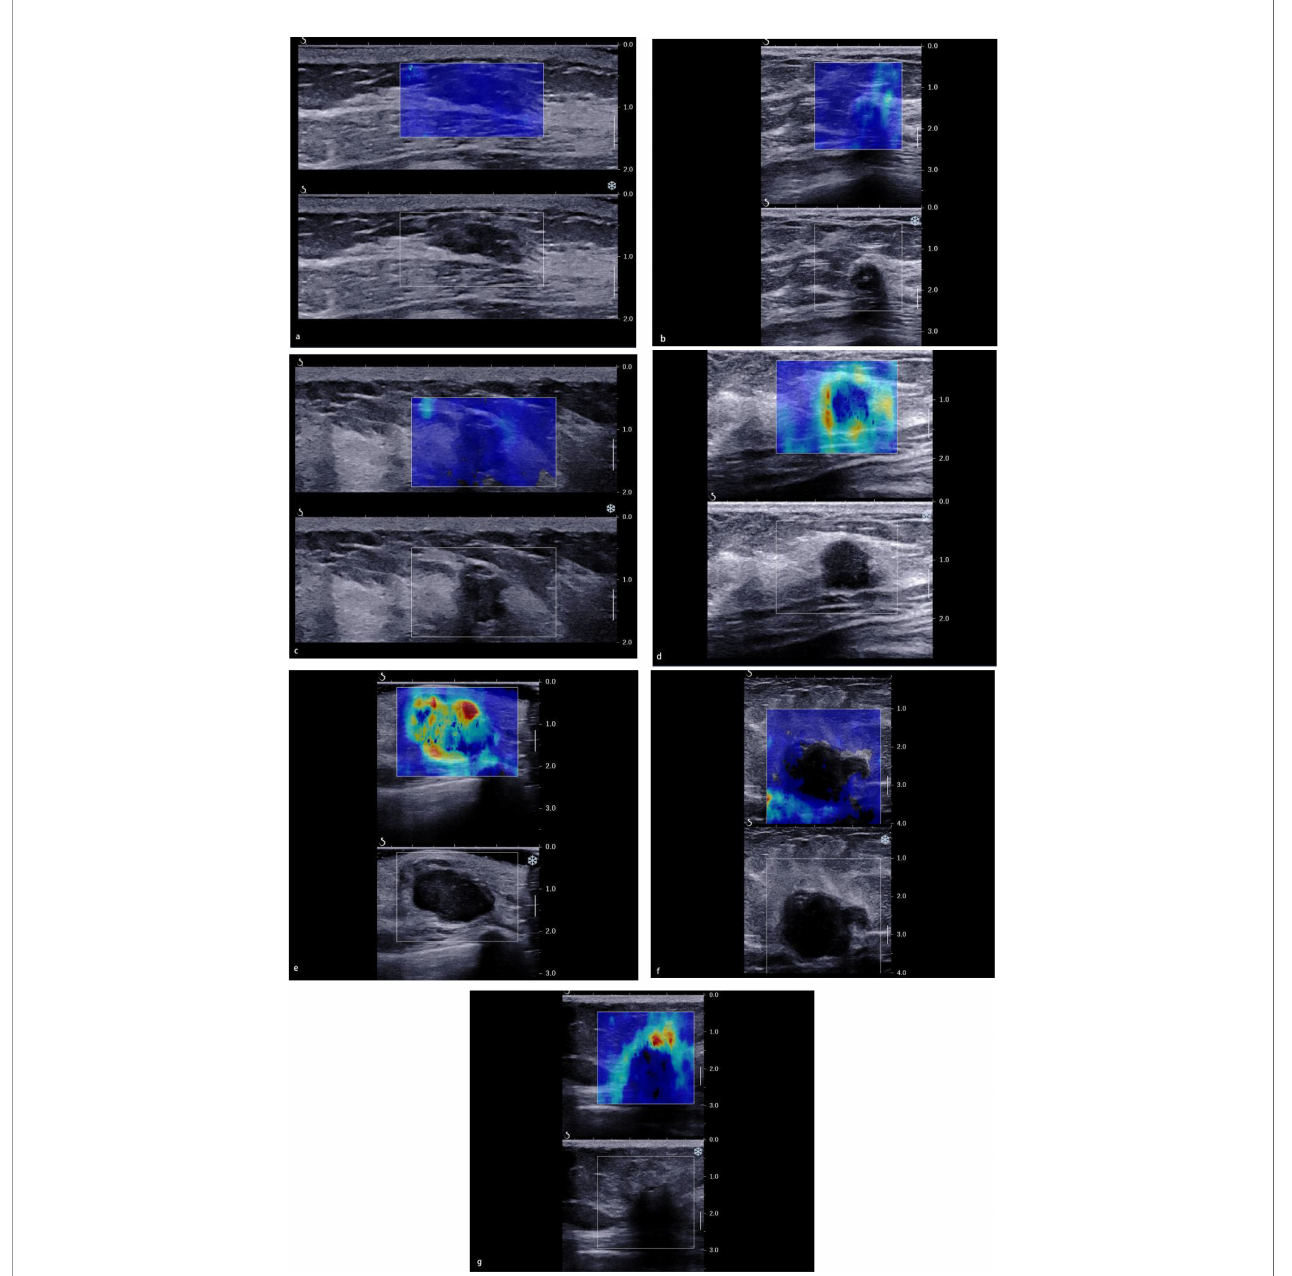
FIGURE 2 | The color pattern features of shear wave elastography. (A) No fi nding. (B) Vertical stripes pattern. (C) Spots pattern. (D) Rim of stiffness pattern. (E) Colored lesion pattern. (F) Void center pattern. (G) Horseshoe